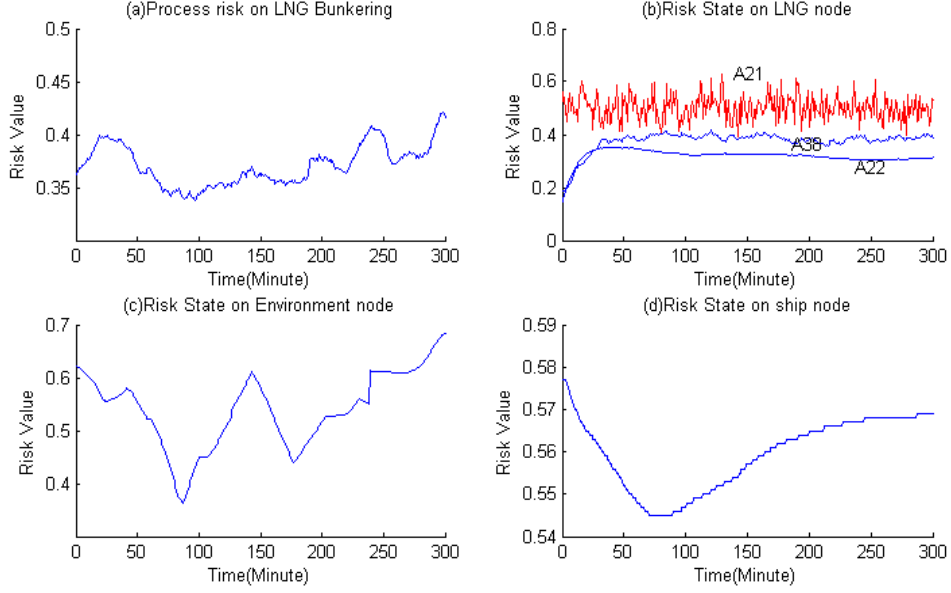
Figure 5. Fueling process risk, human-ship-environment sub-system risk. ( a ) Process risk on LNG ship Bunkering. ( b ) Risk State on LNG node. ( c ) Risk State on Environment node. ( d ) Risk State on ship node.